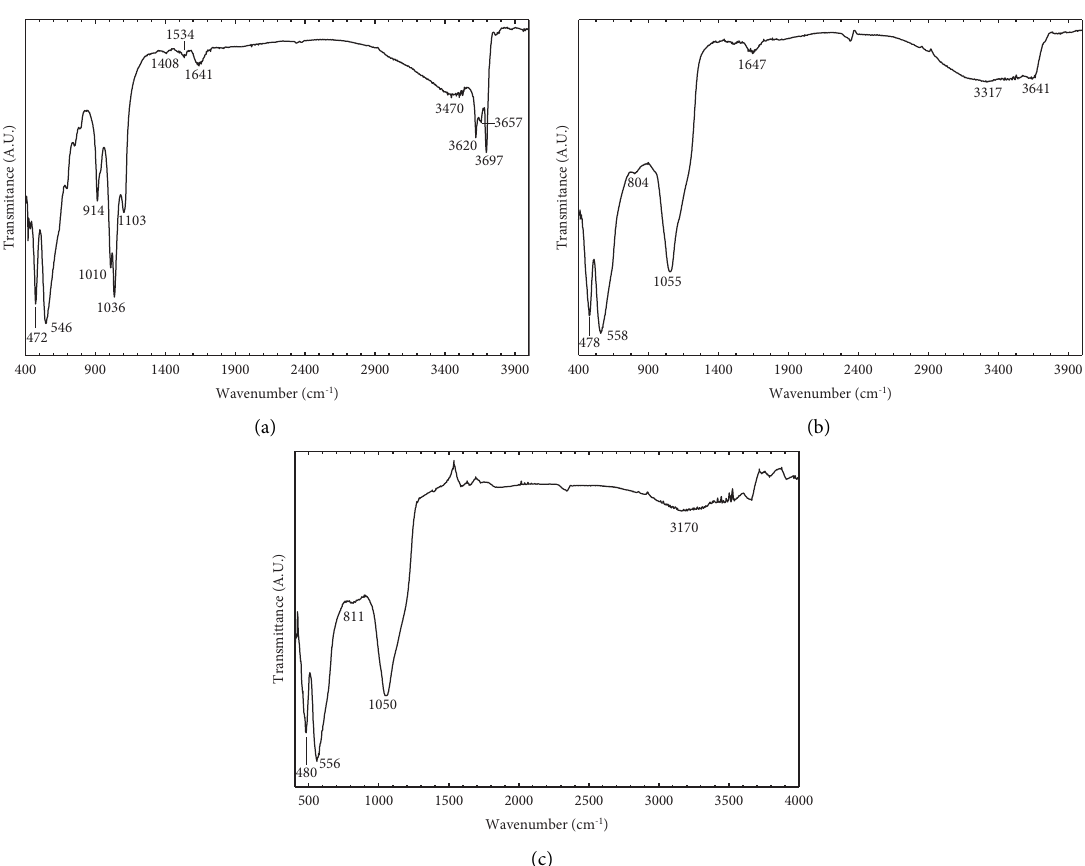
Figure 11: Effect of heating on the DRIFT spectra of DPAD200: (a) 270 ° C, (b) 450 ° C, and (c) 600 ° C.